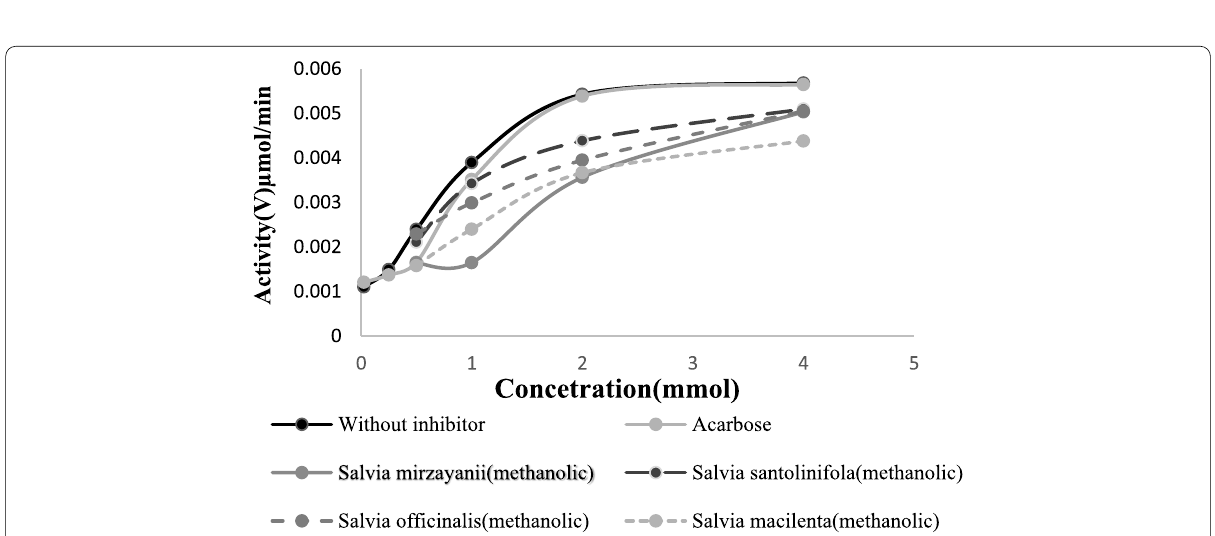
Fig. 2 Michaelis Menten curves of methanolic extracts of Salvia species in comparison to reaction without inhibitor and acarbose as a